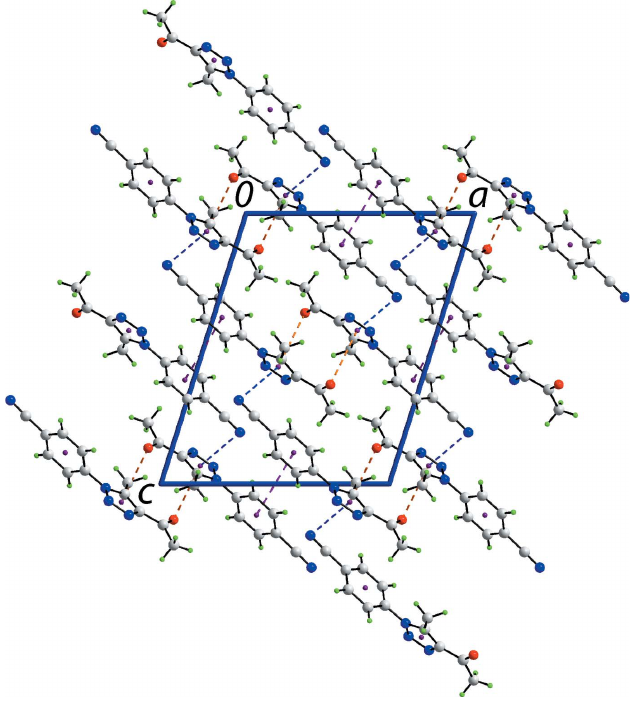
Figure 1 The molecular structure of (I), showing the atom-labelling scheme and displacement ellipsoids at the 50% probability